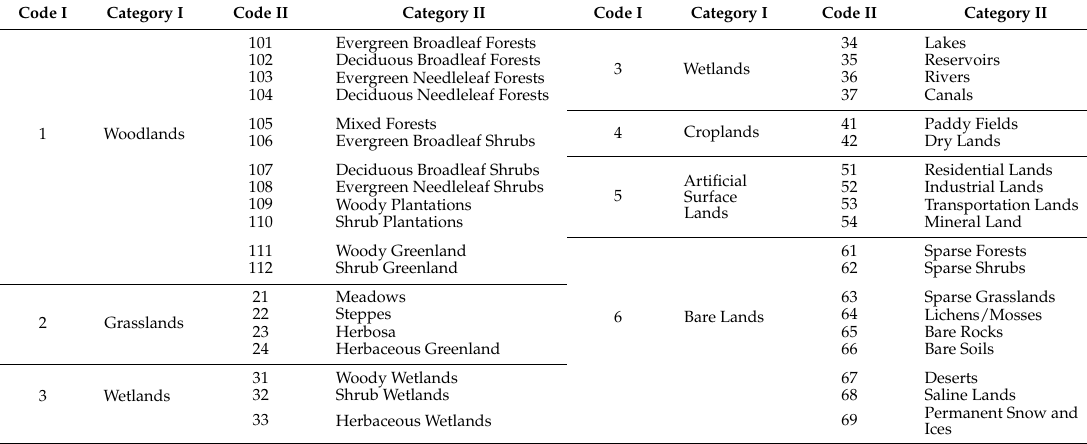
Table 1. Land cover classification system of the CLC-SW2010